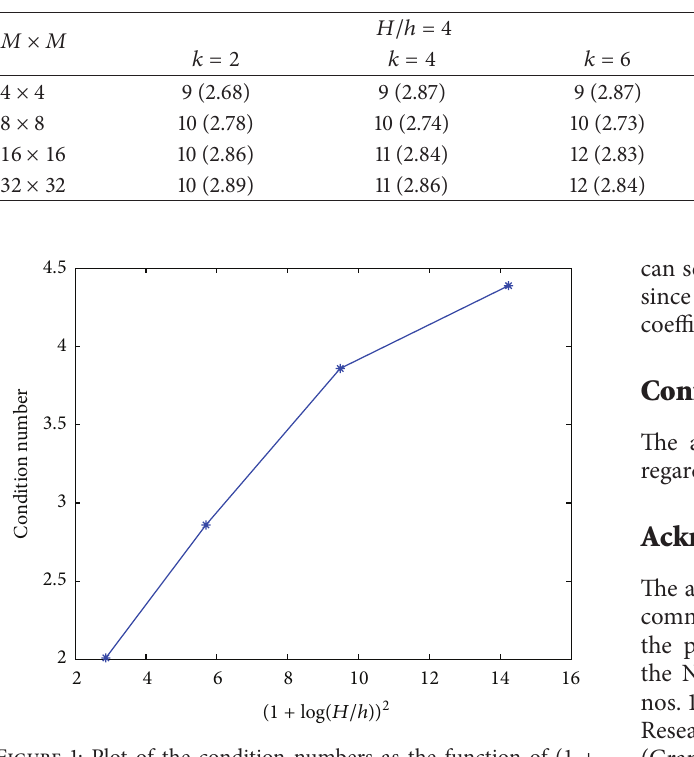
Table 1: The number of iterations and condition numbers.